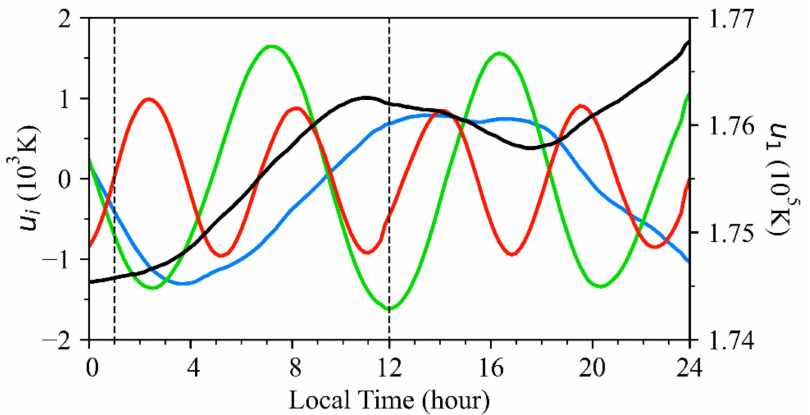
Figure 8. Variation of PC coefficients 1 (black), 20 (blue), 40 (green), 60 (red) with time and the → u 1 corresponds to the right axis, others correspond to the left selected times (black dotted line). axis. The horizontal axis represents the local time at 135 ◦ E on 11 May 2021. The black dotted lines represent the time used in the following PCA component diagrams (Figures 9 and